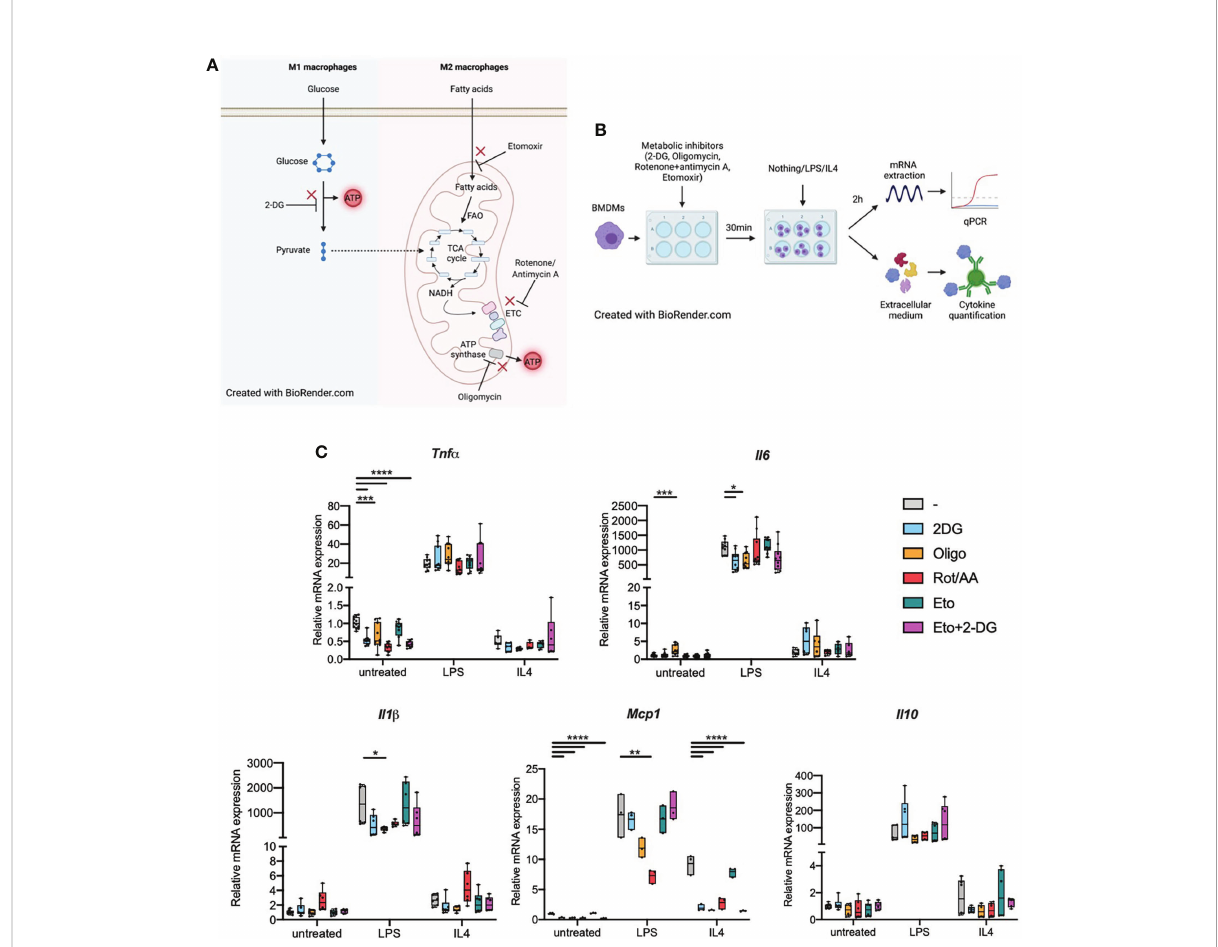
FIGURE 1 Metabolic inhibitors alter macrophage expression of in fl ammatory genes in response to LPS or IL4 (A) . M1 and M2 macrophage metabolism. FAO: fatty acid oxidation. ETC, Electron transport chain; TCA cycle, tricarboxylic acid cycle. (B) Experimental design: bone marrow-derived macrophages (BMDMs) were treated with metabolic inhibitors for 30 min. BMDMs were then either left untreated (M0 quiescent macrophages) or stimulated with LPS or IL4 to induce M1 and M2 polarizations respectively. Macrophage response was then assessed by quantifying cytokine concentration in the extracellular medium or through mRNA quanti fi cation by qPCR. (C) Relative mRNA expression for Tnfa , Il6 , Il1b , Mcp1 and Il10 in quiescent BMDMs either left untreated or treated with 2-deoxyglucose (2-DG), oligomycin (Oligo), rotenone/antimycin A (Rot/AA), Etomoxir (Eto) or a combination of 2-DG and Etomoxir (Eto+2-DG). All points are shown in box plots with line at median. One-way ANOVA was used to determine statistical signi fi cance between groups within each stimulation condition (untreated, LPS, IL4) *p < 0.05, **p < 0.01, ***p < 0,001, ****p < 0,0001. Unless otherwise stated, differences between groups are not statistically signi fi cant. A and B Created with